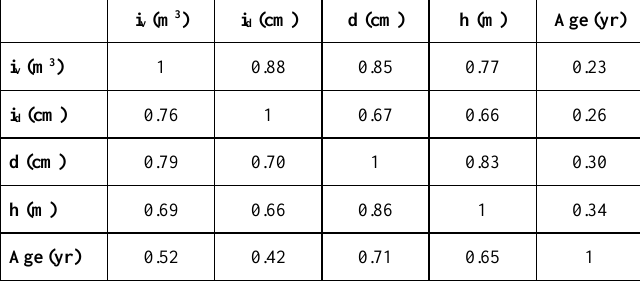
Table 3. Correlation coefficient matrix table (based on Antanajtisz & Zagreev,